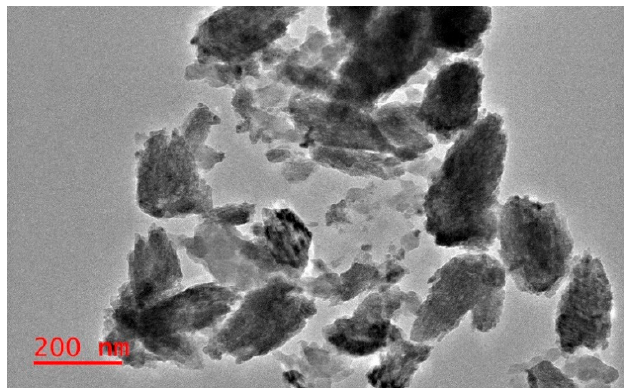
Figure 4. Typical TEM image of synthesized ZnO-NPs-PF.